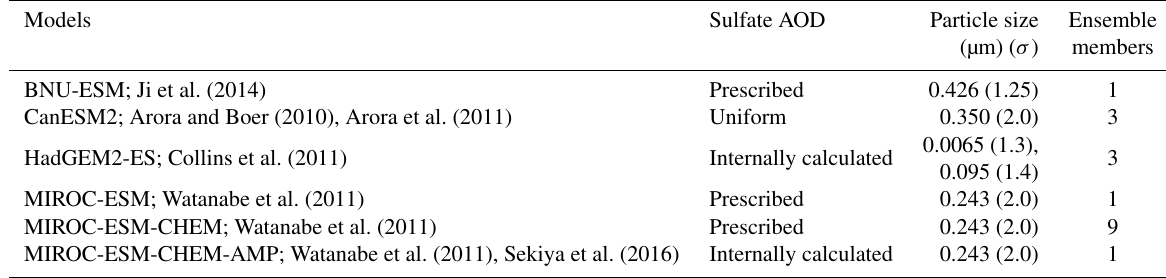
(µm) ( σ ) members 0.0065 (1.3), 3 0.095 (1.4)